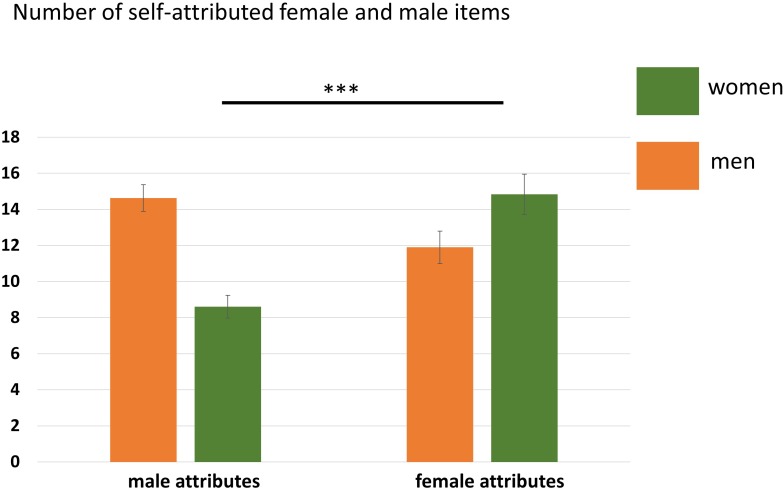
Number of agreed items in the self-condition separated for women and men. Women agreed to significantly more female than male attributes. Error bars indicate the standard error of the mean (SEM). ∗∗∗p < 0.001.